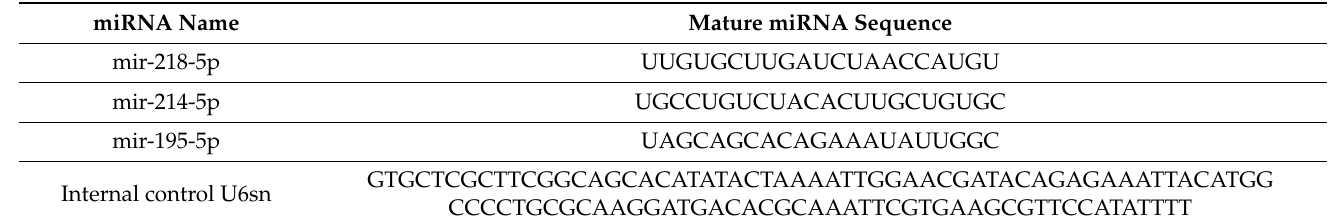
Table 2. Taqman microRNA